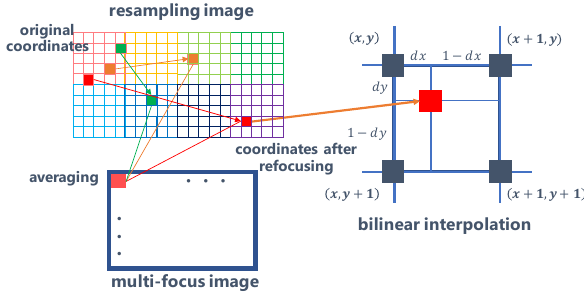
Figure 9. Multi-focus image generation